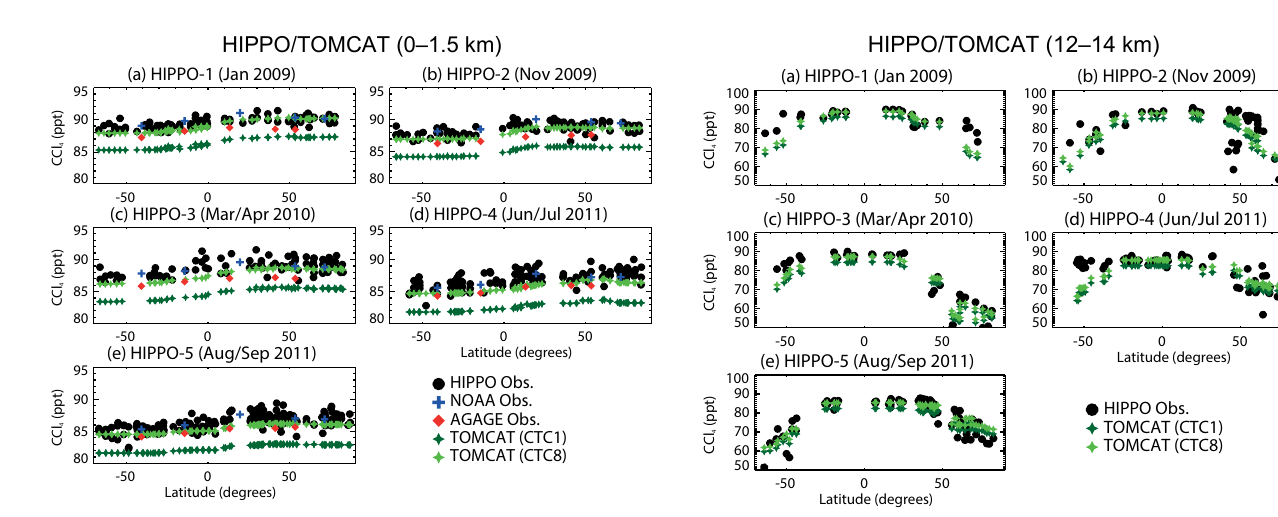
Figure 5. Latitude cross section of HIPPO observations of CCl 4 (ppt, black circles) between 12 and 14km altitude from flights dur- ing five campaigns between January 2009 and September 2011. Re- sults from model tracers CTC1 and CTC8 are also